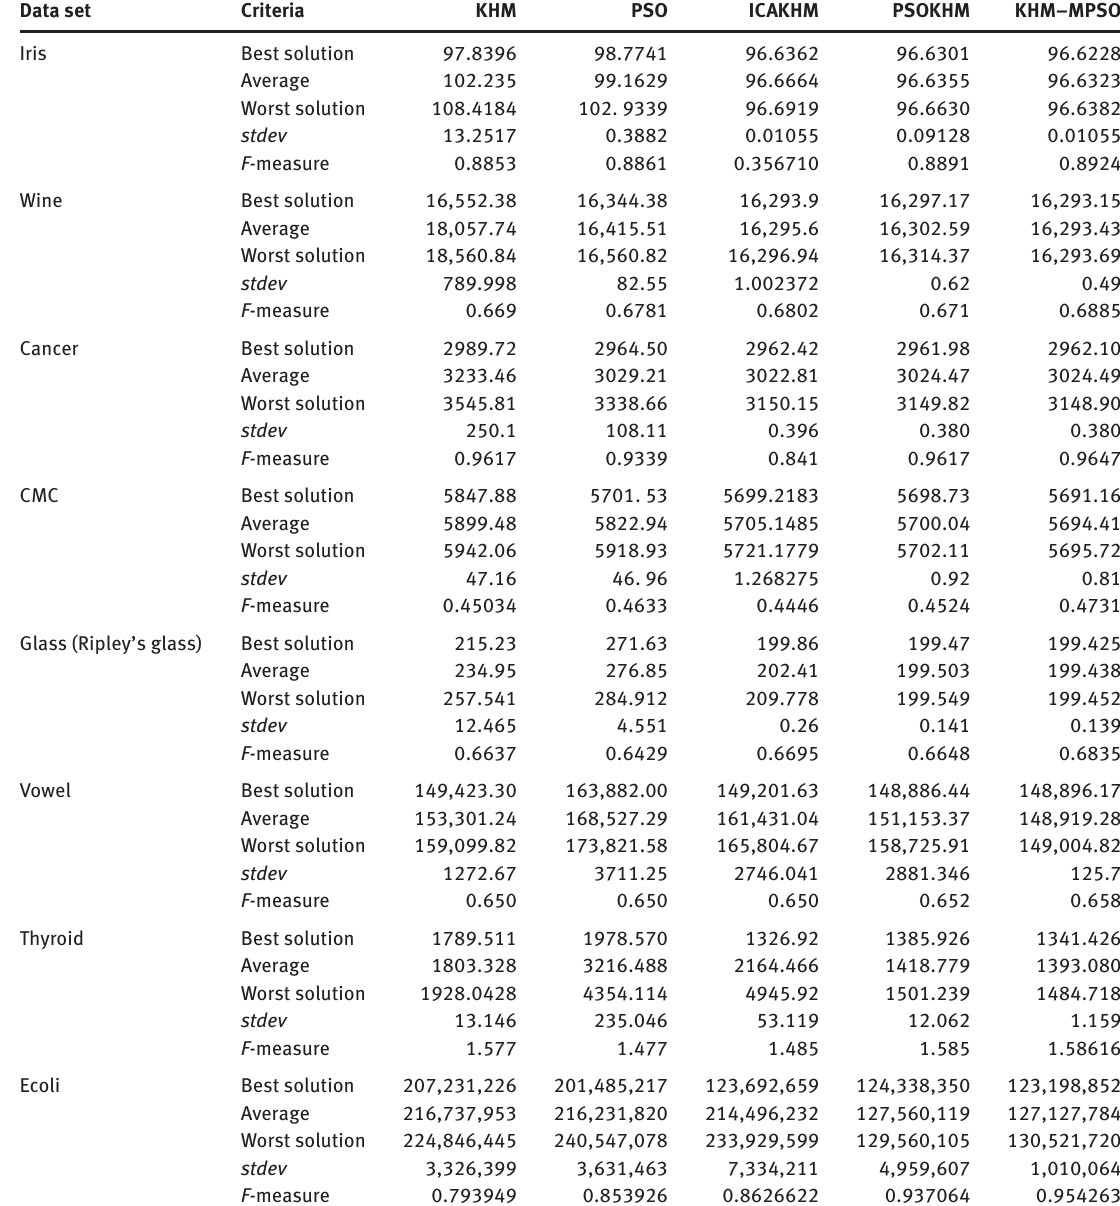
Table 3: Simulation Results of 100 Runs of the Following Clustering Algorithms ( p = 2.5). Data set